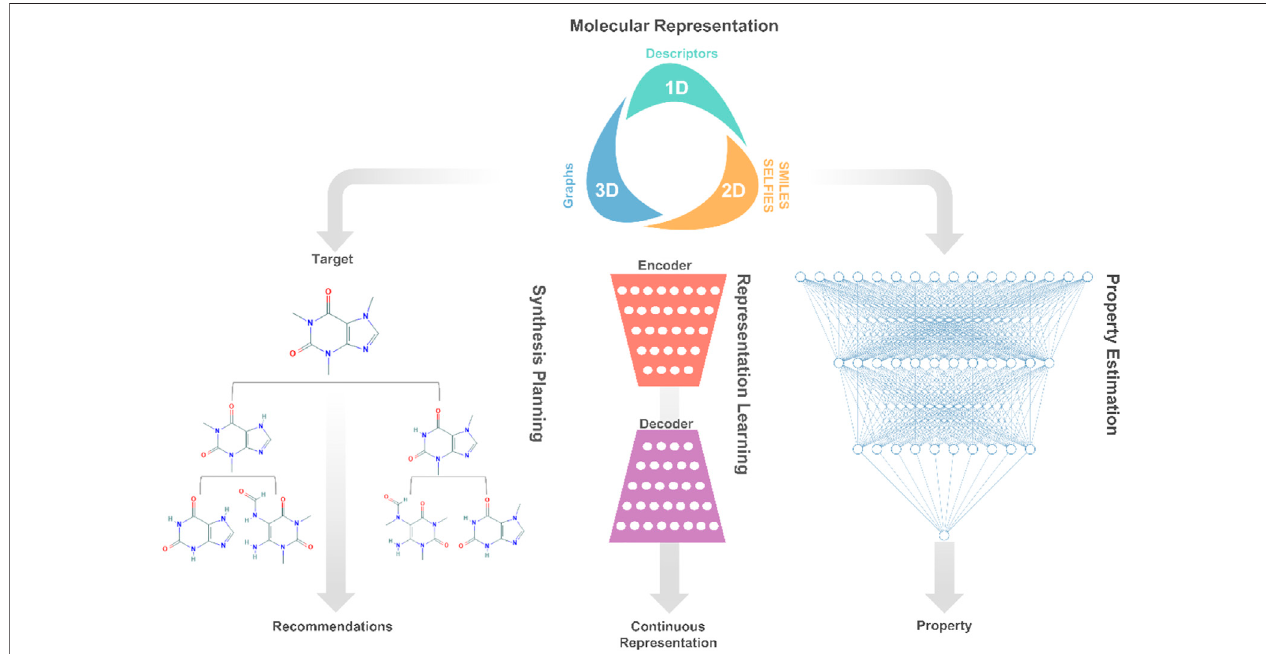
FIGURE 1 | A high-level description of prominent deep learning applications involved in molecular systems engineering and design.